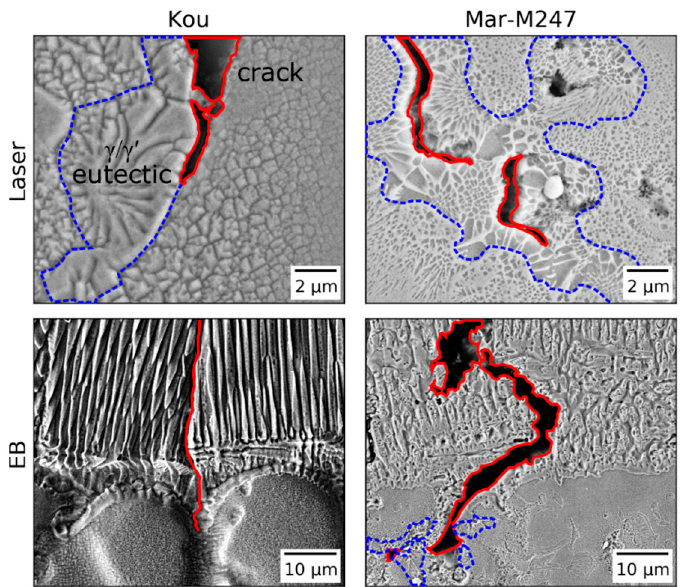
Figure 7. Details of crack tips and surrounding microstructure in Kou and Mar-M247 alloys. Areas consisting of γ / γ′ eutectic are marked in blue; cracks are highlighted in red.